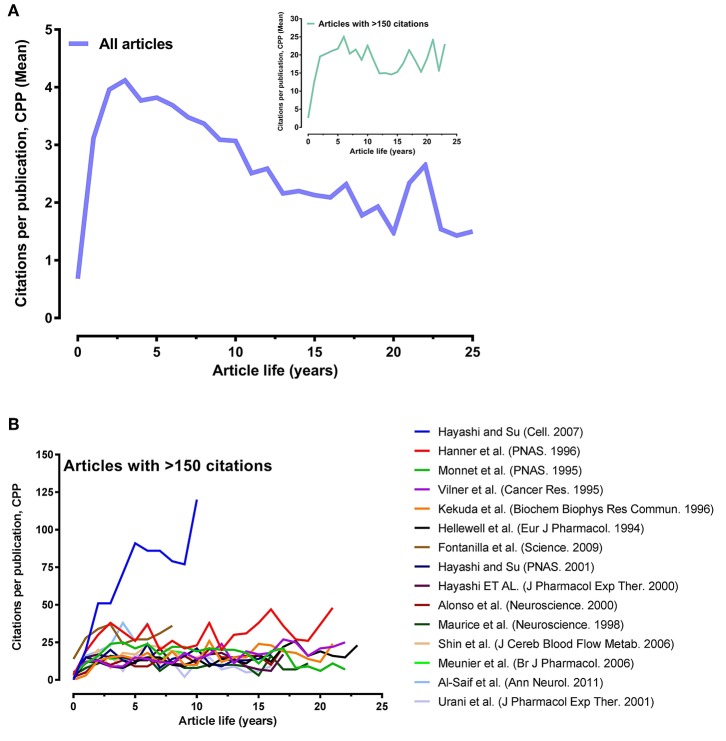
Variations of citations per publication (CPP) with article lifespan. (A) Mean CPP with article lifespan for all 1102 articles and for those with more than 150 citations (insert graph). (B) CPP values of each highly cited article over the years.